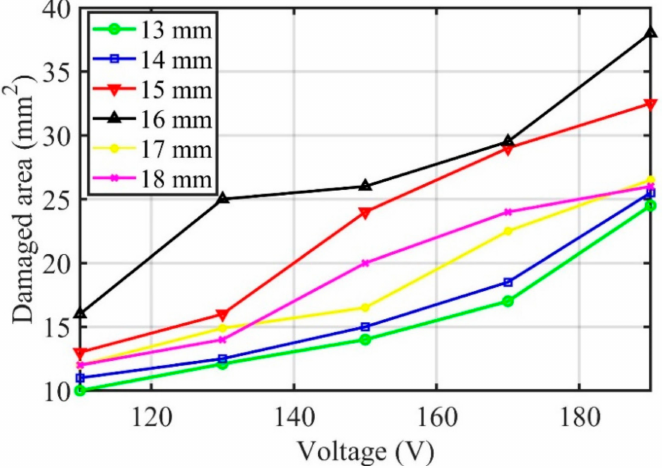
Figure 6. The damaged area of aluminum foils around the metallic rods at different experimental